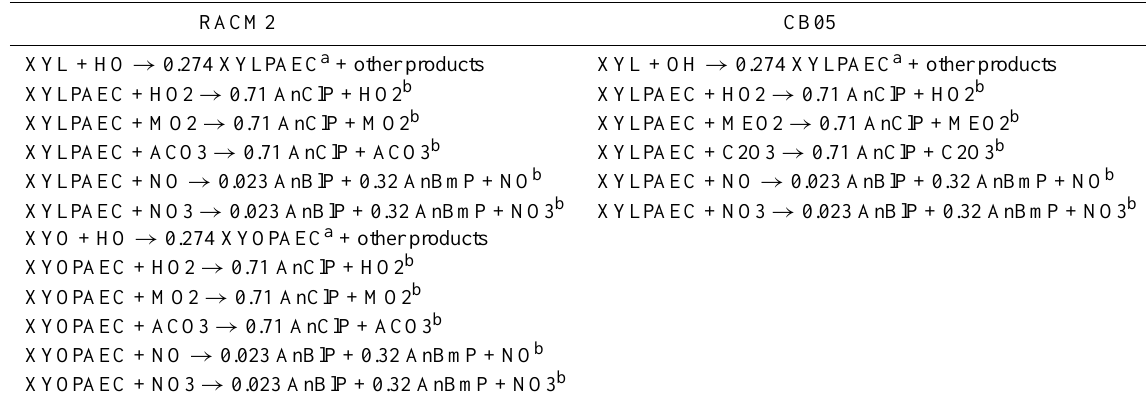
Table 3b. Xylenes oxidation chemistry for SVOC formation. RACM2 CB05